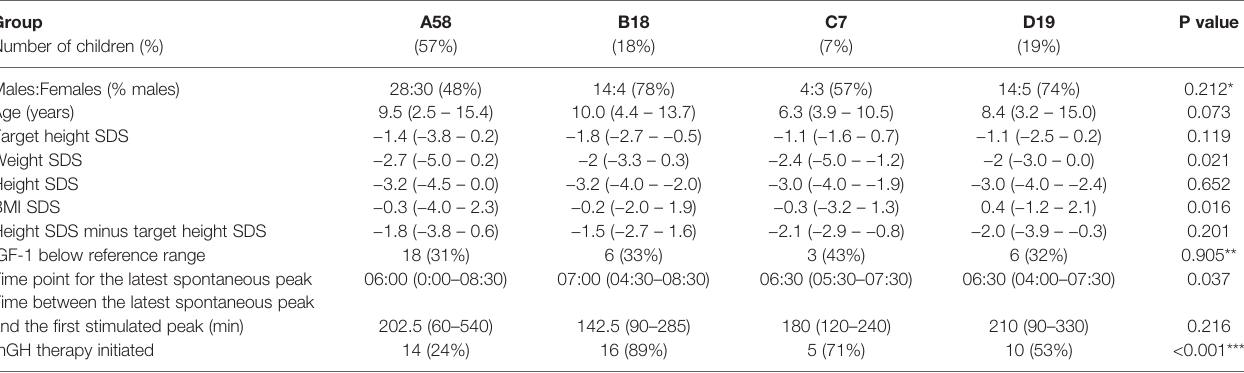
TABLE 2 | Clinical characteristics of short children evaluated with both a nocturnal spontaneous GH test and an AITT. The patients are divided into groups based on having concordant or divergent results in the tests when applying 7 µg/L as the arbitrary cut-off for peak GH values in both tests. Group Number of children (%)